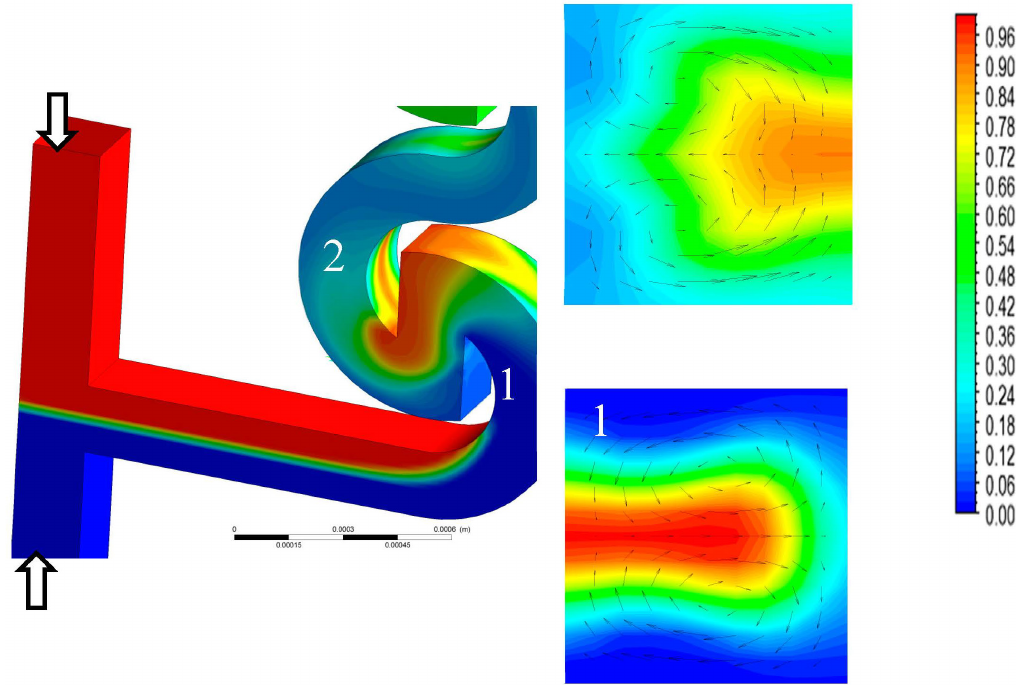
Figure 4. Dean vortices at Re = 50 at sections 1 and 2 of the first semicircle-mixing unit.